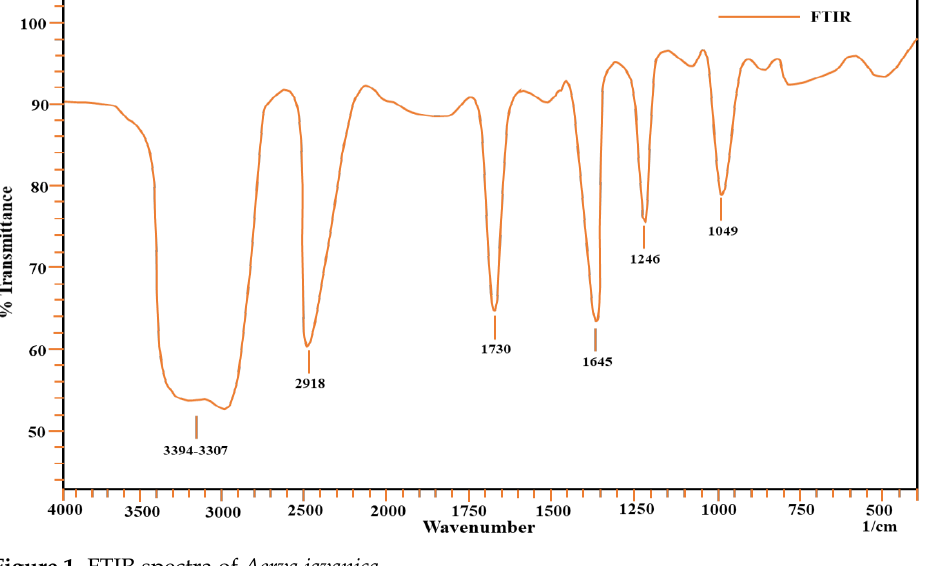
Figure 1. FTIR spectra of Aerva javanica.